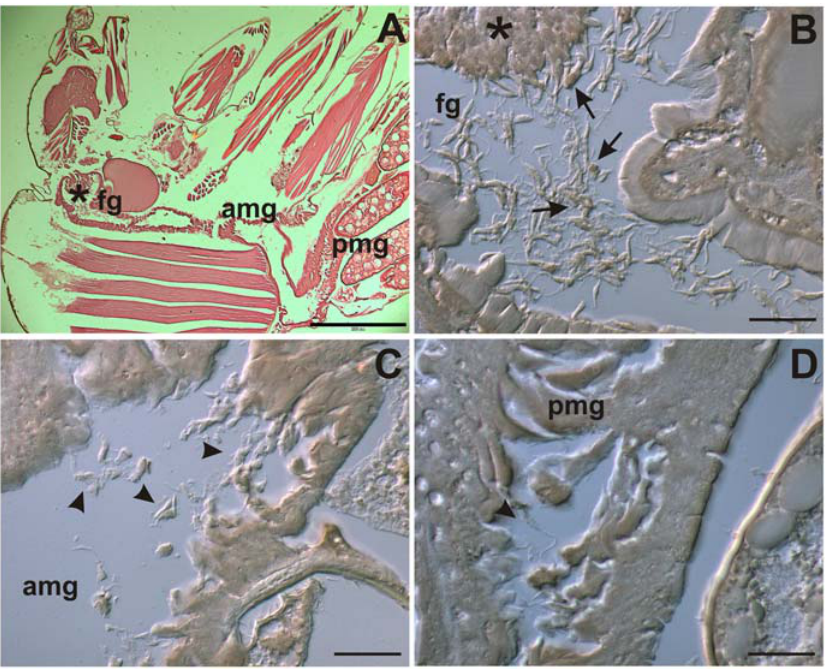
Figure 7. TUNEL POS promastigotes are present in the intestinal tract of infected sand flies. Lutzomyia longipalpis sand flies were fed with mice blood containing infected macrophages. After 10 days female insects were fixed and histochemical analysis for TUNEL labeling was performed. ( A ) Hematoxilin-eosin stain showing overview of sand fly section. ( B ) Parasite concentration at the bulbous cardia region of the foregut and isolated and clumped TUNEL POS promastigotes in the foregut (fg). Most of the stained parasites are already acquiring a round-shaped morphology (arrows). ( C ) and ( D ) elongated TUNEL NEG promastigotes in respectively the anterior midgut (amg) and posterior midgut (pmg) of infected sand flies (arrowheads). Bars represent 200 m m (A) and 20 m m (B, C and D). Asterisks on panels A and B indicate the bulbous cardia region of the foregut.